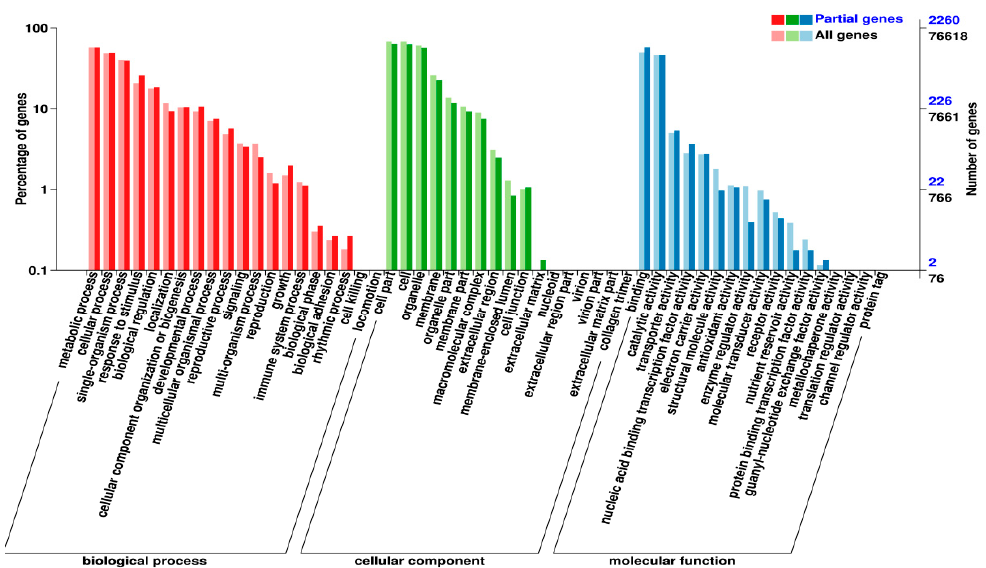
Figure 4. Functional classification of the target genes of the DEMs, referring to the GO database. Table 1. Major metabolic pathways related to wheat tillering ( P <